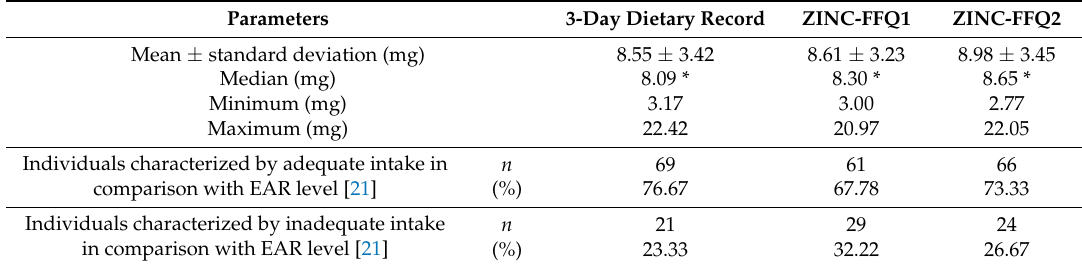
Table 3. The observed zinc intake and the assessment of its adequacy.